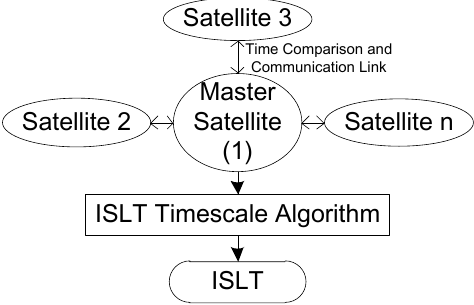
Figure 1. A brief establishment framework of inter-satellite link time (ISLT).